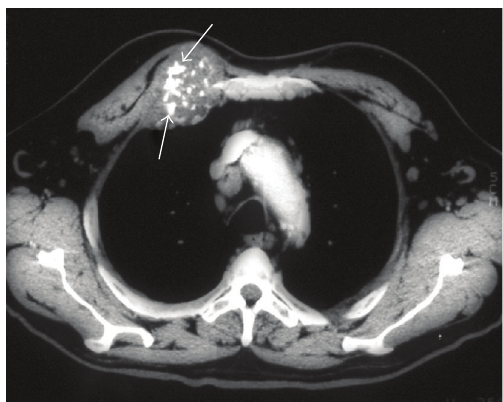
Figure 2: Typical CT appearance of an anterior chest wall chon- drosarcoma arising from the chondrosternal junction, demonstrat- ing prominent chondroid matrix mineralization resulting in a characteristic flocculent or “popcorn” pattern of calcification